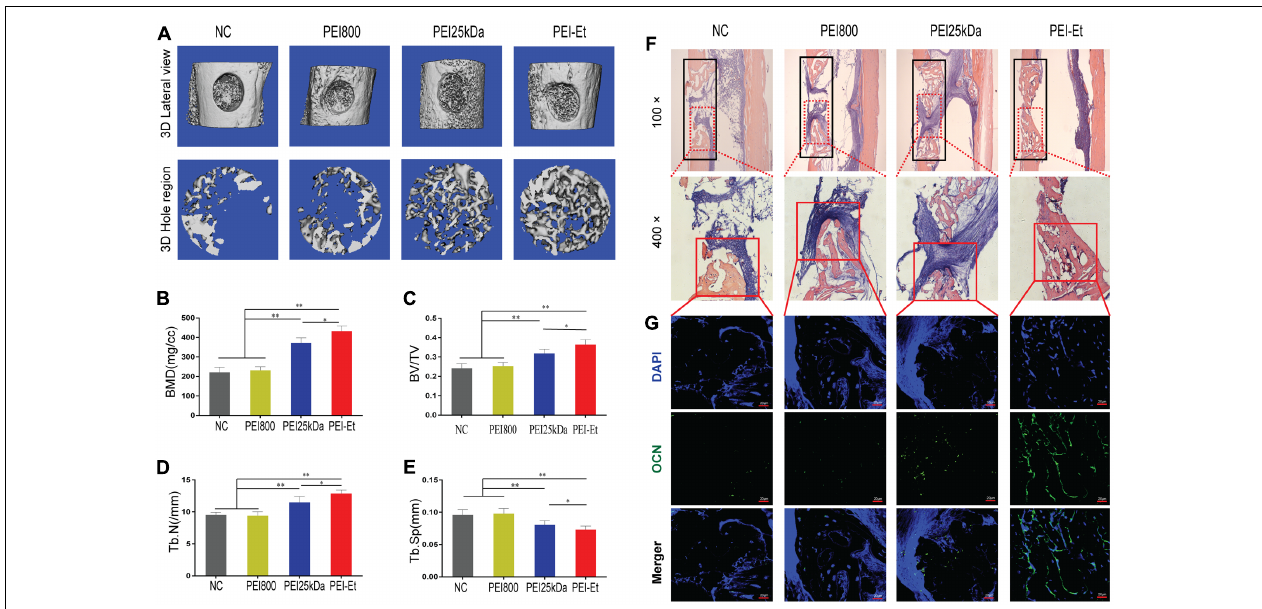
FIGURE 7 | Chordin knockdown promotes the bone regeneration of hBMSCs in vivo . (A) Lateral views of 3D reconstruction of injured tibiae (Top) and mineralized bone formed in hole region (Lower) by µ CT. Representative images from each group, N = 5. (B–E) 3D structural parameters- BMD, BV/TV, Tb.N and Tb.Sp-of mineralized bone formed in hole region by µ CT, N = 5. (F) Representative images of H&E staining showed new bone formation in injured tibiae (black frame in top panel with 100 × and lower panel with 400 × ). (G) Immunofluorescent assay of OCN expression in the new bone. ∗ P < 0.05, ∗∗ P < 0.01.